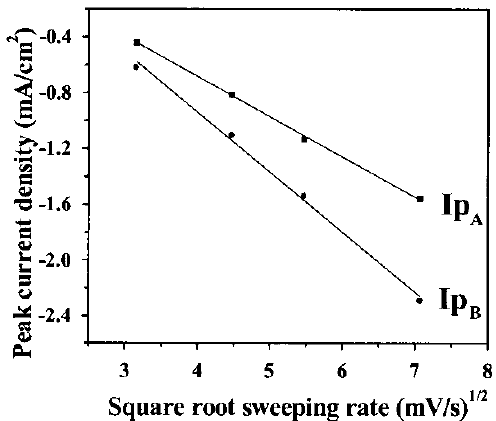
FIGURE 9 Peak current densities versus square root sweeping rates. ( Ip A ): first reduction peak, ( Ip B ): second reduction